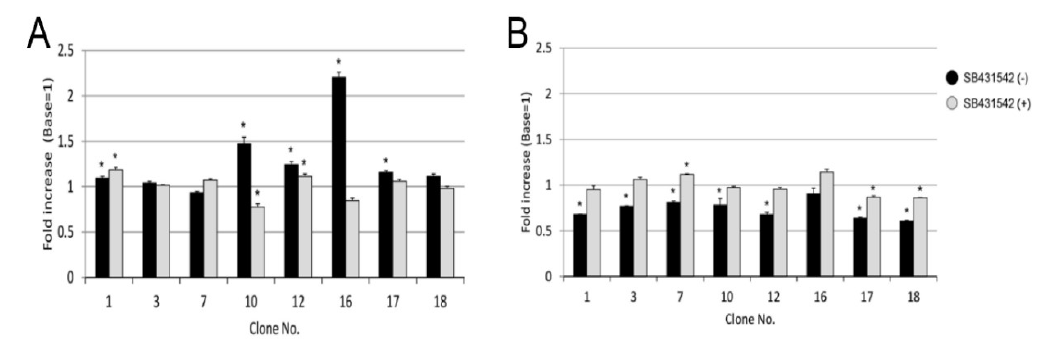
Figure A2. Effect of BMP2 and TGF-β1 on inherent ALP activity of porcine dental pulp-derived cell lines. Effect of ( A ) BMP2 with or without LDN-193189, and ( B ) TGF-β1 with or without SB431542. Values of inherent ALP activity are indicated as the fold increase, when the activity of the control was 1. Data are means ± standard error (SEM) of 6 culture wells (* p < 0.05).